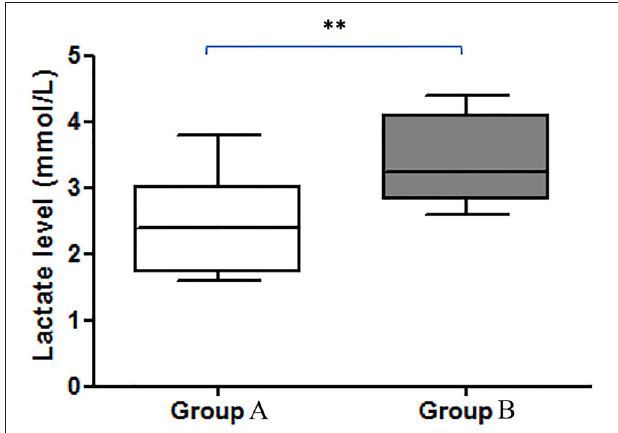
FIGURE 1 | Comparison of the blood lactate levels (mmol/L) between groups. There was a significant difference between the increase in lactate in group A and group B (** p < 0.01). Group A included dogs with normal right ventricular function, and group B included dogs with impaired right ventricular